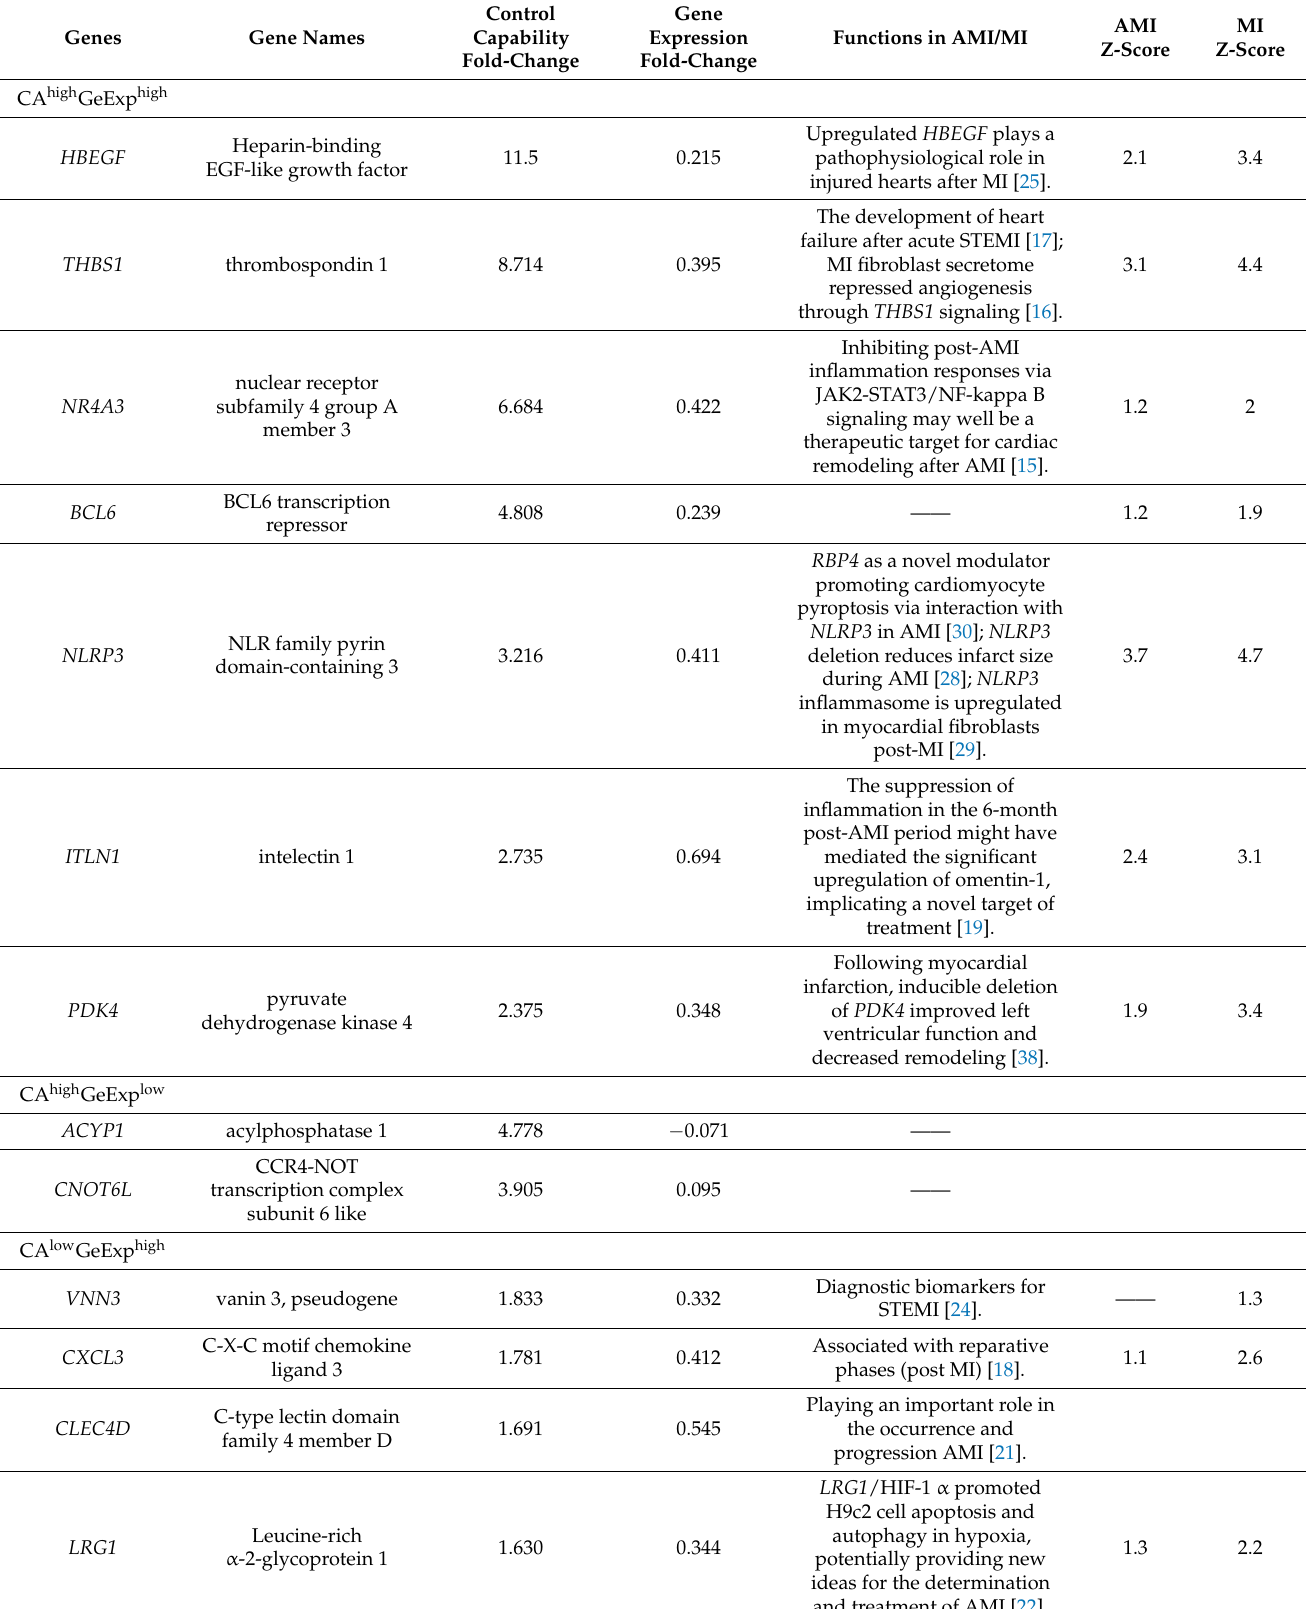
Table 1. Category of